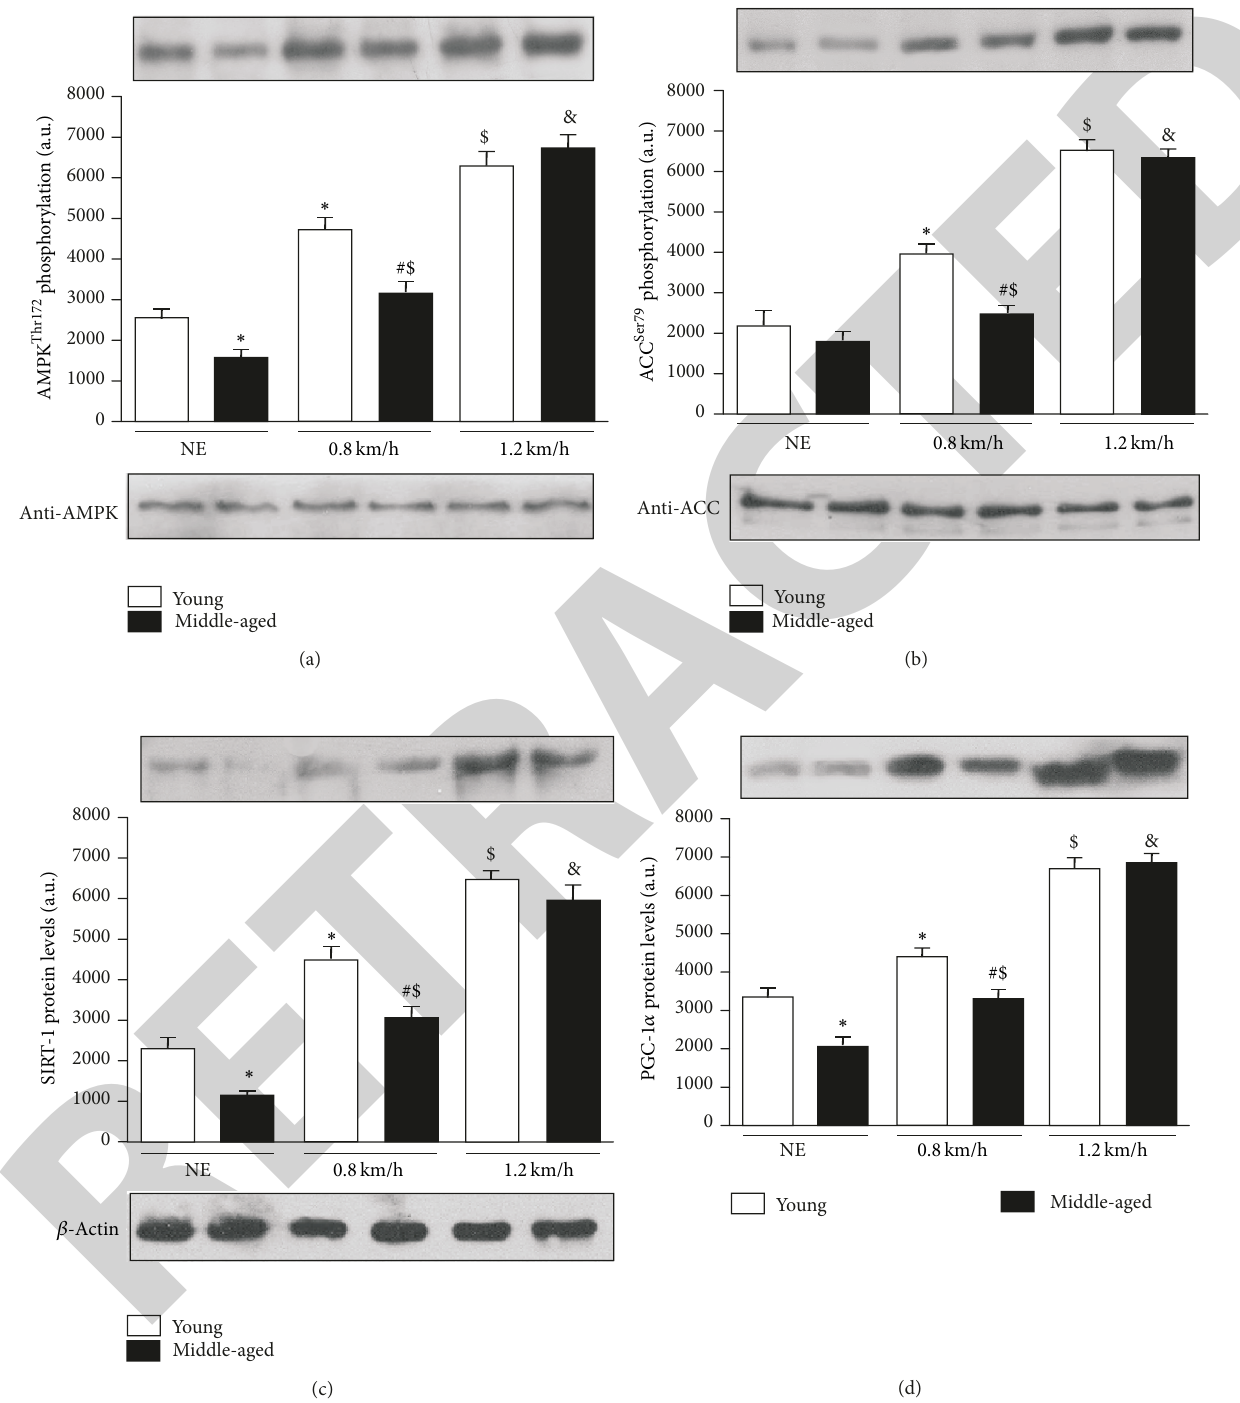
Figure 2: Effects of exercise protocols performed in different intensities on the AMPK and ACC phosphorylation and SIRT-1 and PGC-1 𝛼 protein levels in the quadriceps of young and middle-aged rats. Phosphorylation of the AMPK (a) and ACC (b) and protein levels of SIRT-1 (c) and PGC-1 𝛼 (d). Upper panels show representative blots of these proteins. Lower panels show representative blots of total AMPK (a) and total ACC (b) protein levels. The results of scanning densitometry are expressed as arbitrary units. Bars represent means ± SEM of six rats. ∗ 𝑃 < 0.05 versus young NE rats, # 𝑃 < 0.05 versus middle-aged NE rats, $ 𝑃 < 0.05 versus young rats at 0.8 km / h, and & 𝑃 < 0.05 versus middle-aged rats at 0.8 km /